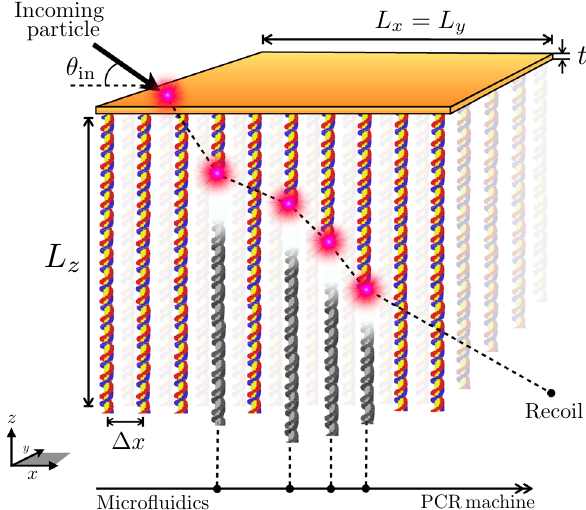
Fig. 1 Diagram of the basic concept behind the DNA detector. The detector consists of a thin, dense inorganic holder of area A = L x L y and thickness t from which a regular grid of DNA strands are attached with an inter-strand spacing (cid:2) x . The DNA strands, when broken by some incoming particle or secondary recoil, fall down to a collecting area where they are transported in chronological order via microfluidics to an amplification and readout stage consisting of polymerase chain reaction (PCR) devices. A PCR device amplifies the collected strands to where the precise sequence of bases can be measured and therefore each vertex in the track can be